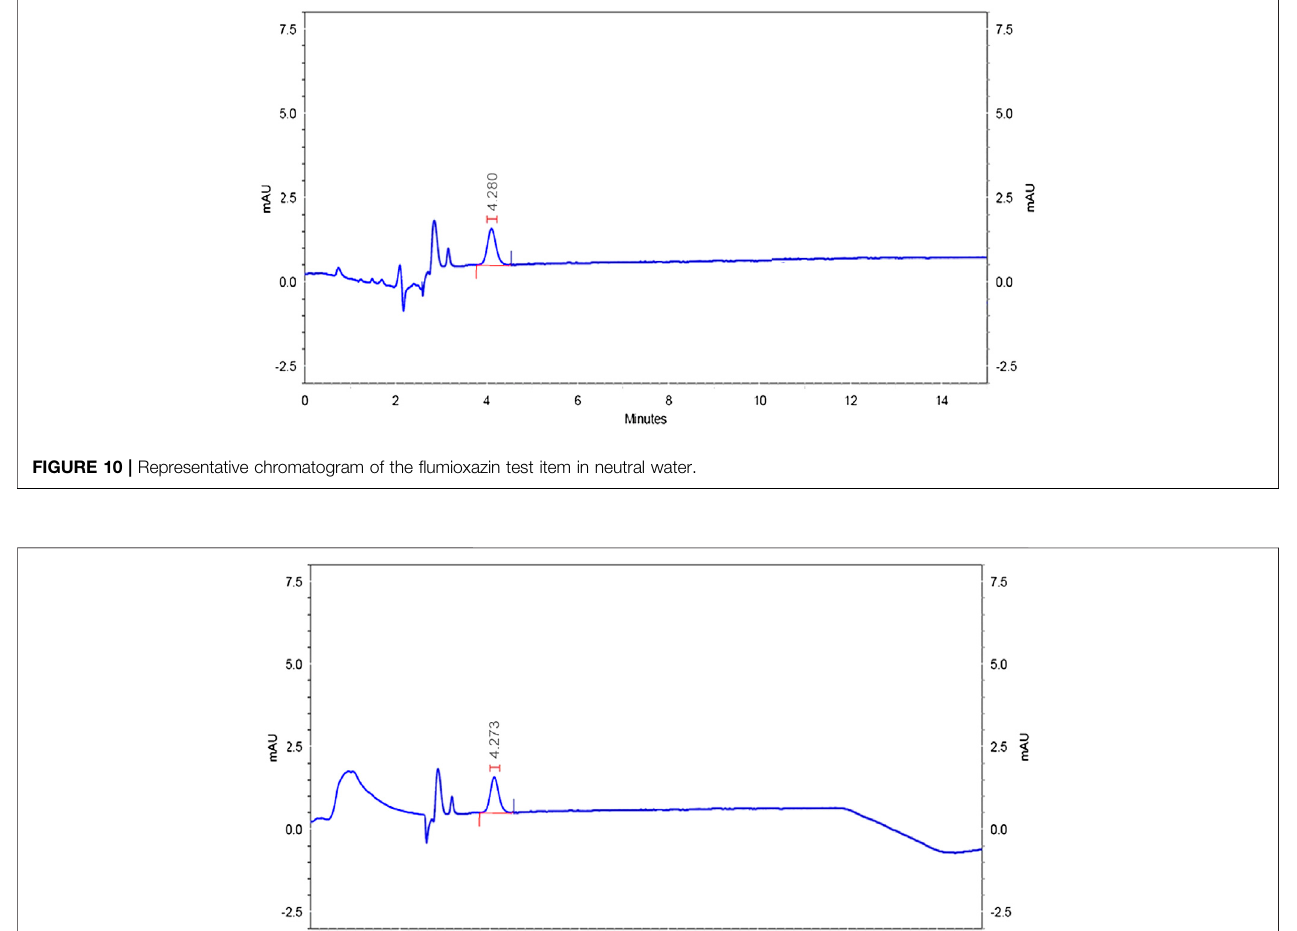
Frontiers in Nanotechnology |